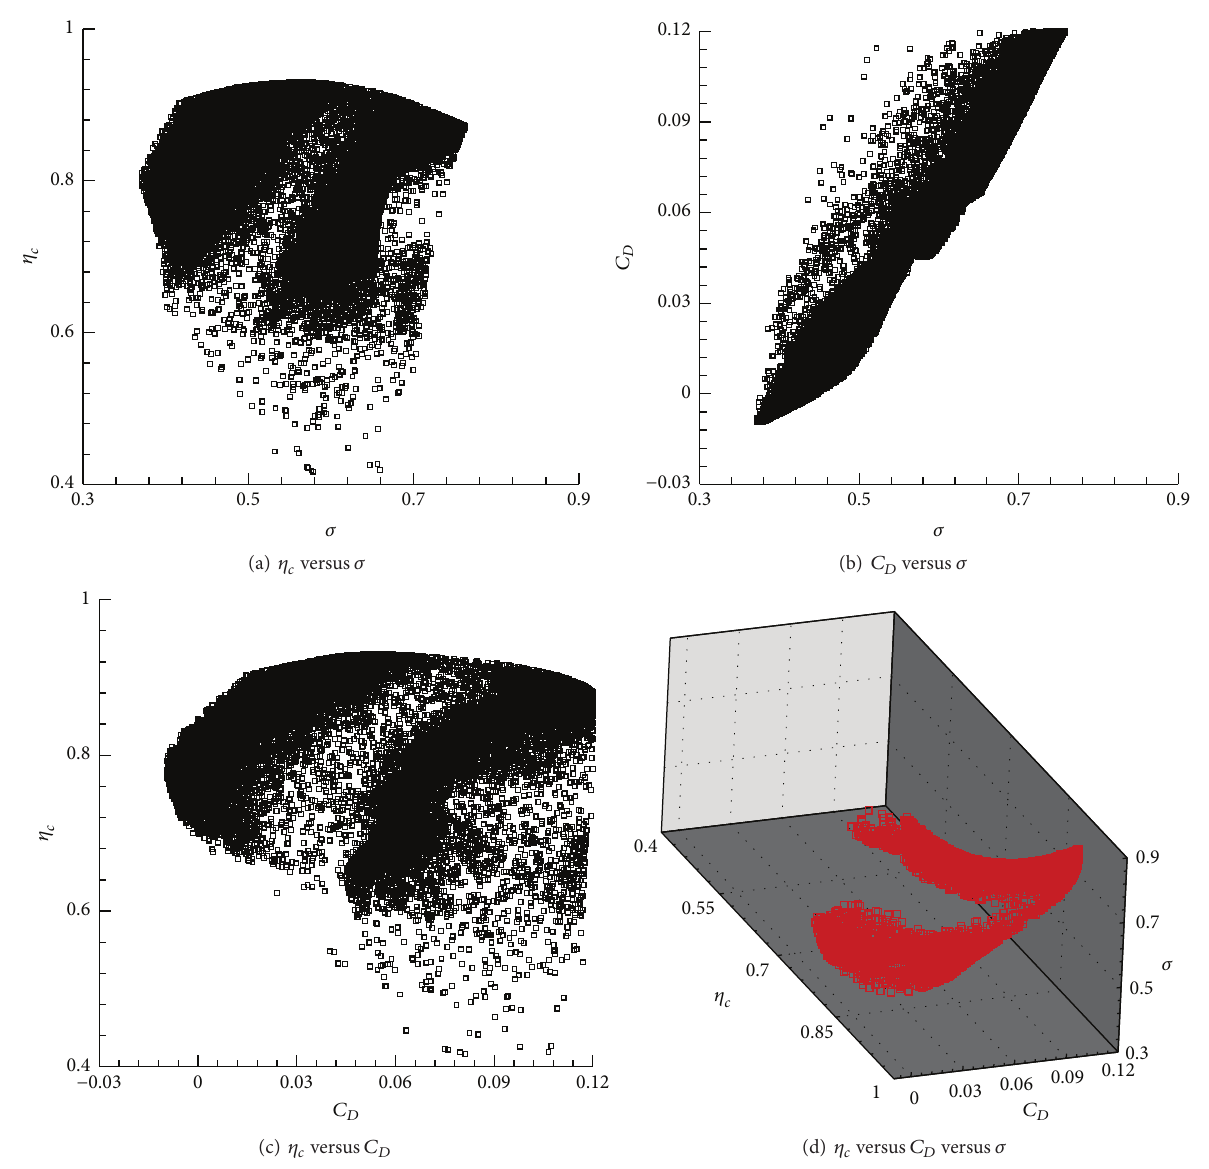
Figure 14: Pareto front for the objective